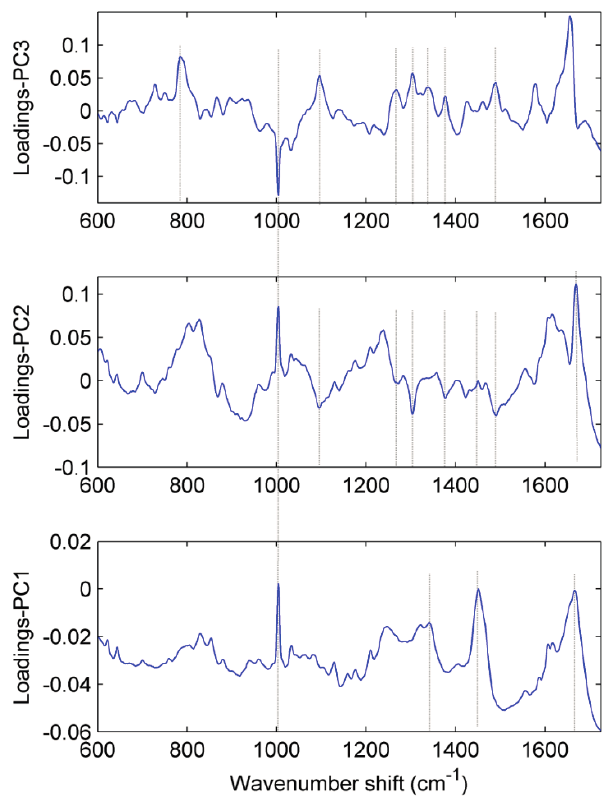
Figure 4. Loading plots relevant to PC1, PC2 and PC3, which are mainly responsible for the discrimination among different clusters of chondrocytes cells associated with different grades of osteoarthritic